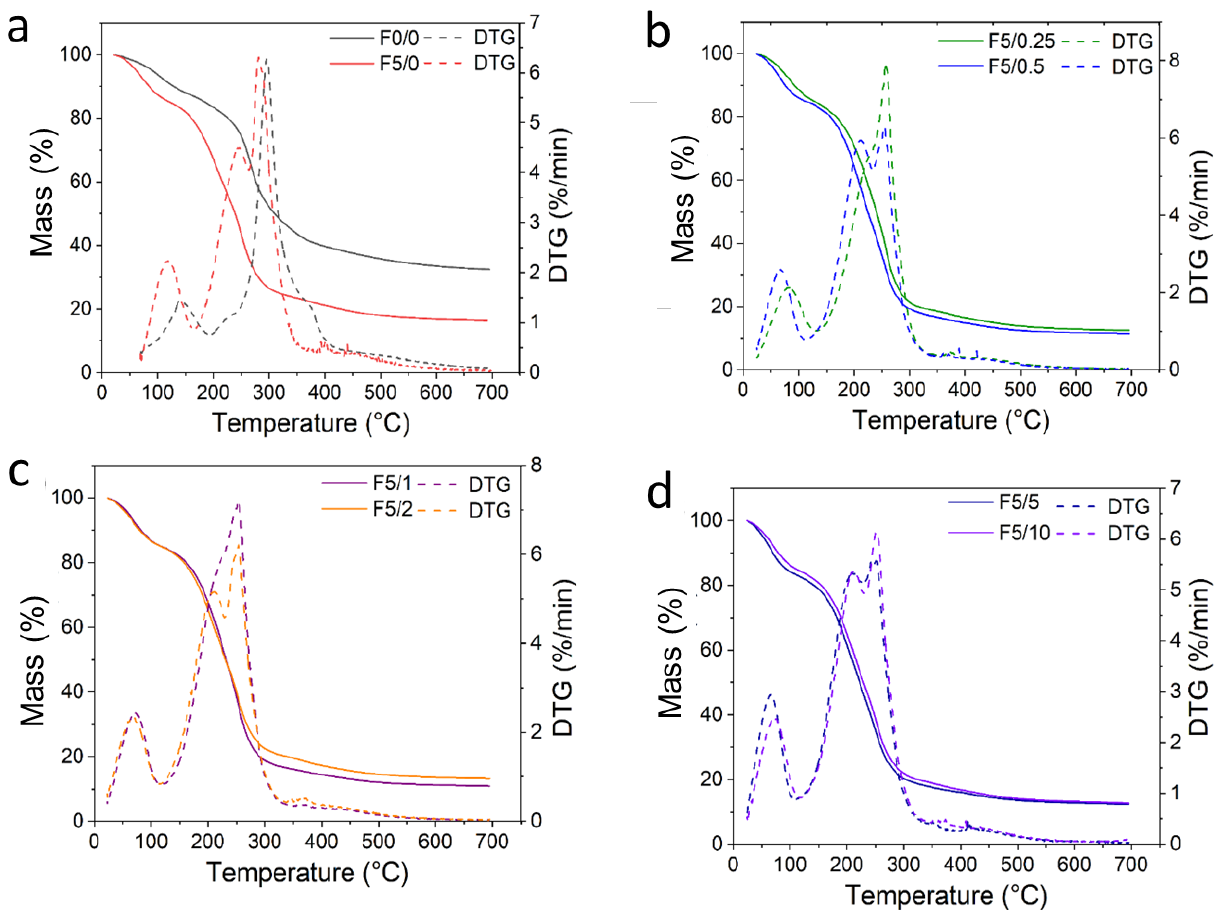
Figure 8. TGA (continuous lines) and DTG (dashed lines) curves for ( a ) CS-based films, F0/0 – F5/0; ( b ) F5/0.25 – F5/0.5; ( c ) F5/1 – F5/2; and ( d ) F5/5 – F5/10.